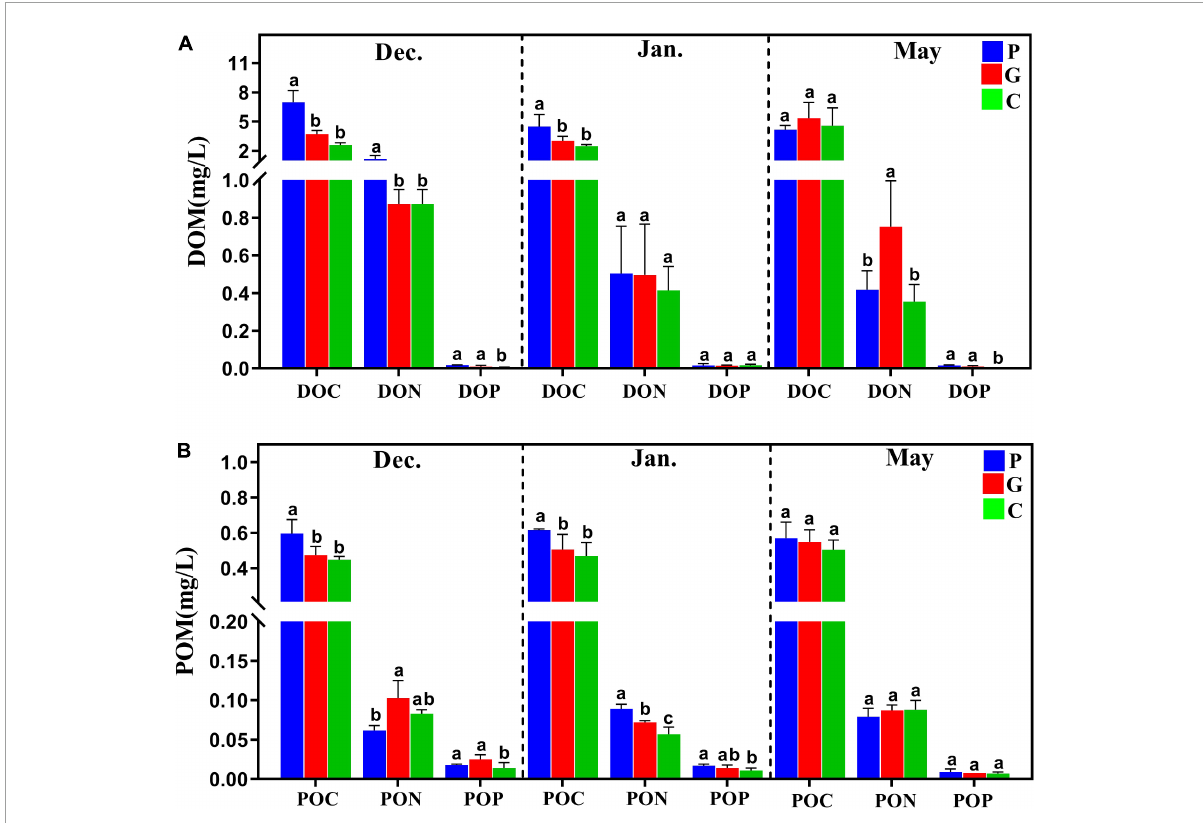
FIGURE1 The dissolved organic matter (DOM) and particulate organic matter (POM) released from three study zones during different periods. (A) DOC, DON, DOP, dissolved organic carbon/nitrogen/phosphorous. (B) POC, PON, POP, particulate organic